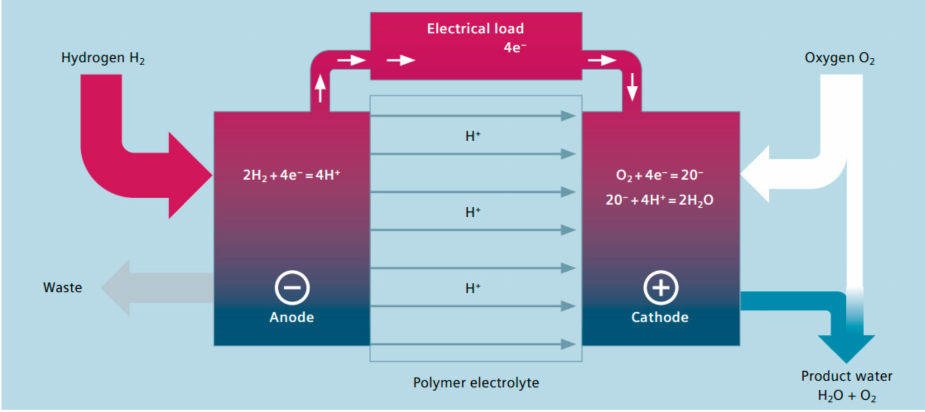
Figure 6. Diagram of a Hydrogen Fuel Cell [54].